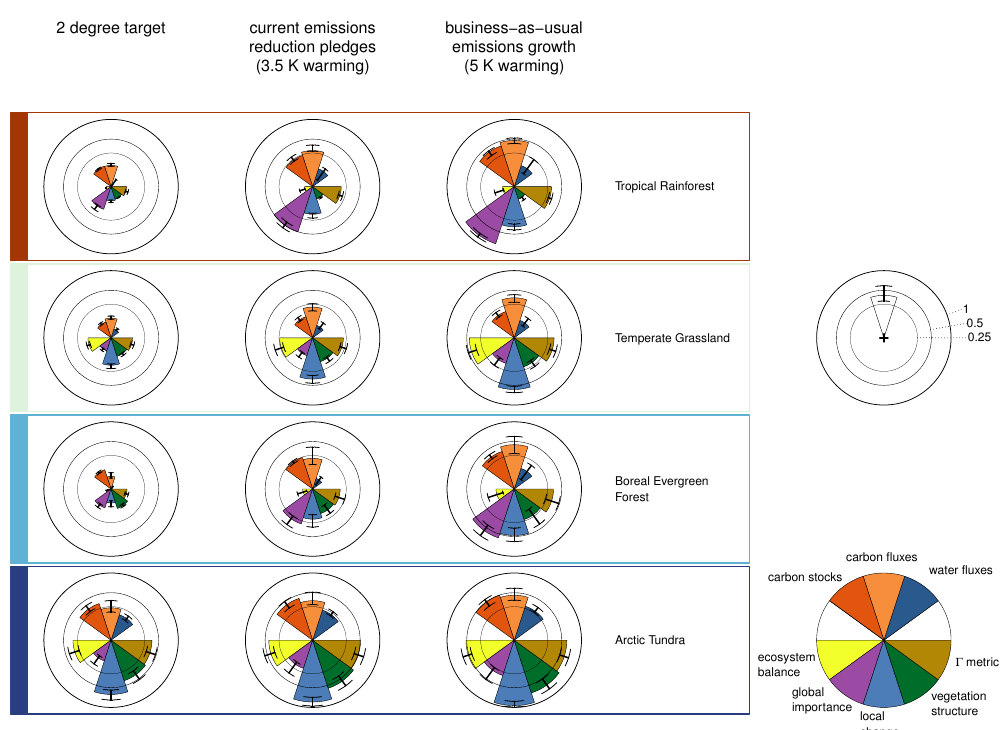
Fig. 4. Dimensions of ecosystem change for select biomes. Components of 0 are averaged over all grid cells belonging to the biome during the reference period. Vegetation structure: 1V ; local change: c · S (c, σ c ) ; global importance: g · S (cid:0) g, σ g (cid:1) ; ecosystem balance: b · S (b, σ b ) . Carbon stocks, fluxes and water fluxes refer to parameter subsets in Table 1. Error bars denote the range across the 19 climate patterns per GMT level. The four largest biomes (except deserts) are presented. For all 16 biome classes, see Fig. S7 in the